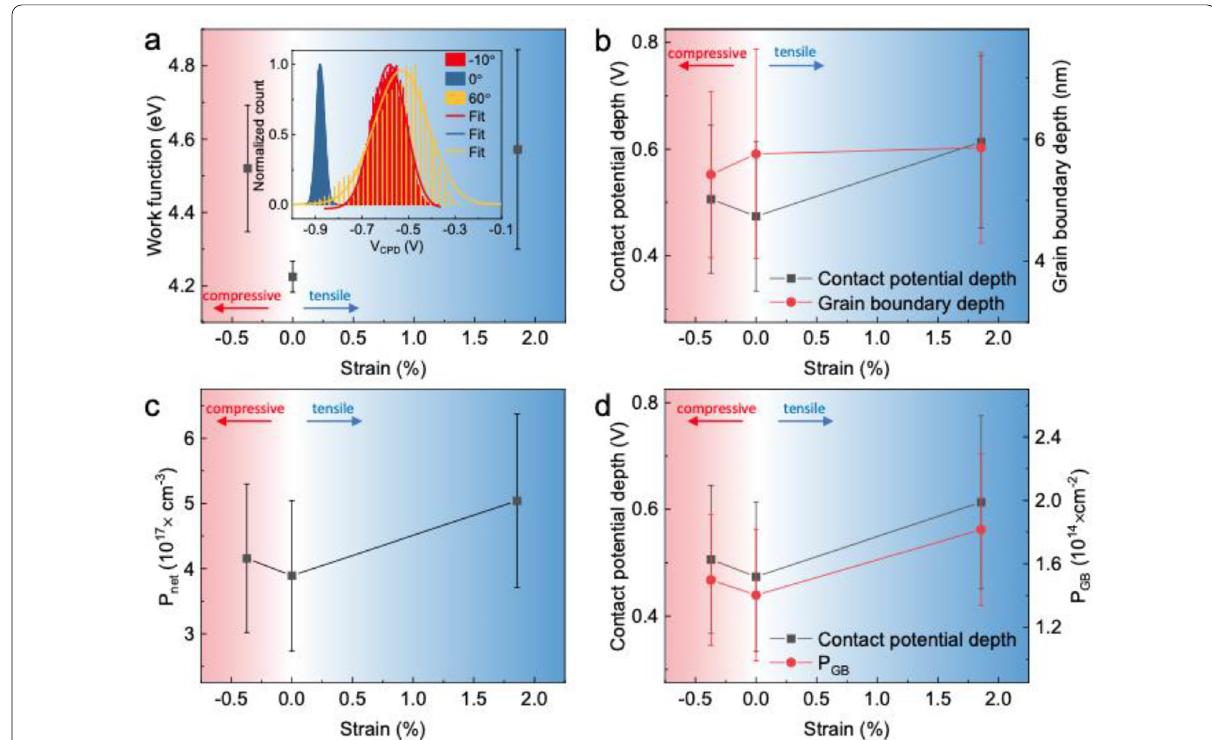
Fig. 6 Grain boundary passivation effect through balancing feedback of hole barrier modulation. a Work function modification under various strains in HfO 2- x . The inset shows histograms of CPD maps. Variation of b the CPD depth (black) and grain boundary depth (red), c the net doping density, P net , and d the CPD depth (black) and defect density (red) at the grain boundary as a function of the